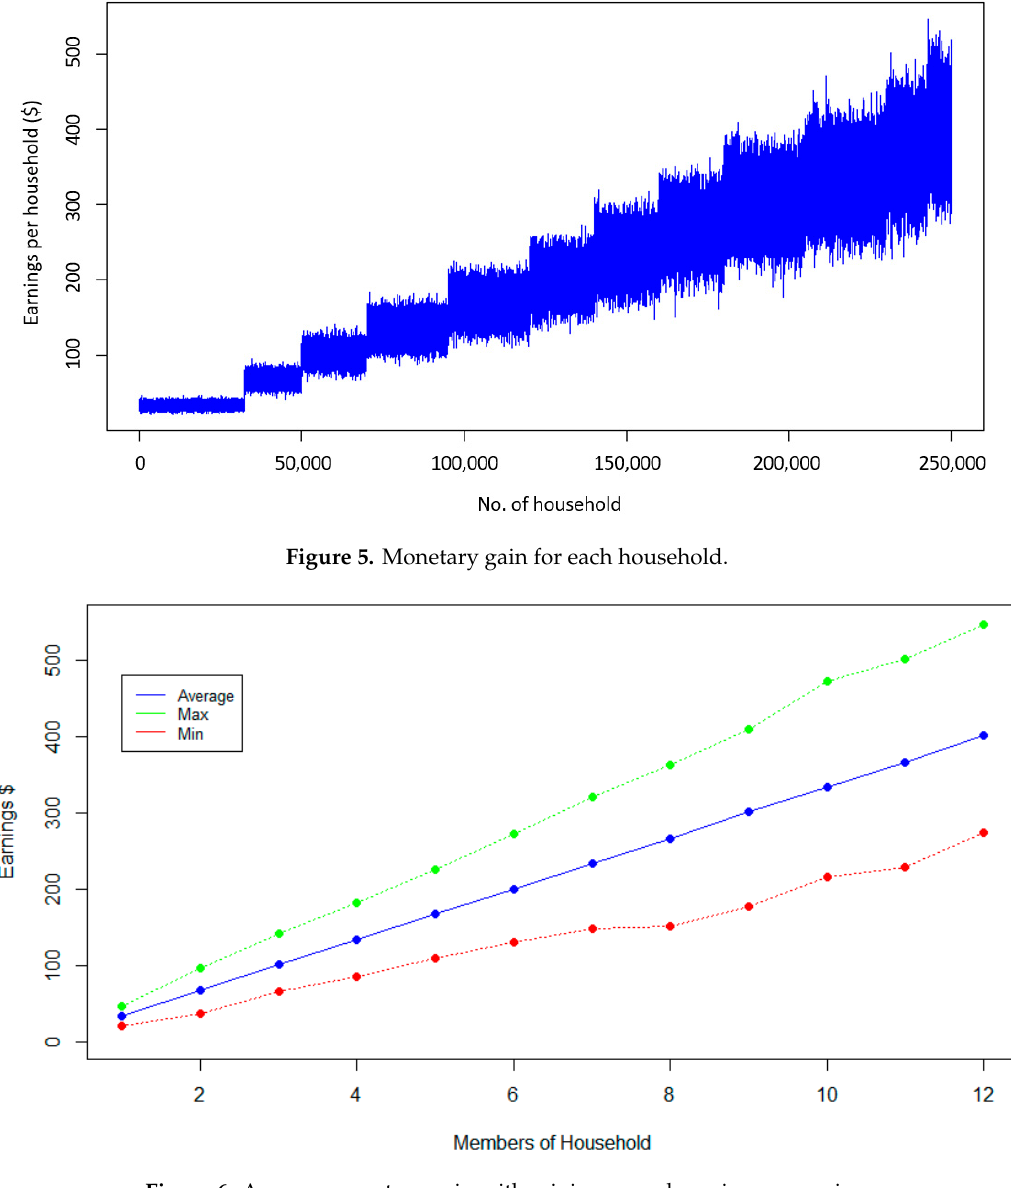
Figure 7. Daily return for ratio. Considering the results from the government’s point of view, this framework is also beneficial, since it can achieve its goal with a relatively low budget. Specifically, a government would have to invest at least 235 million dollars in order to install the required capacity of on shore wind turbines to replace the same amount of energy saved in the simulation for Bahrain. However, the previous